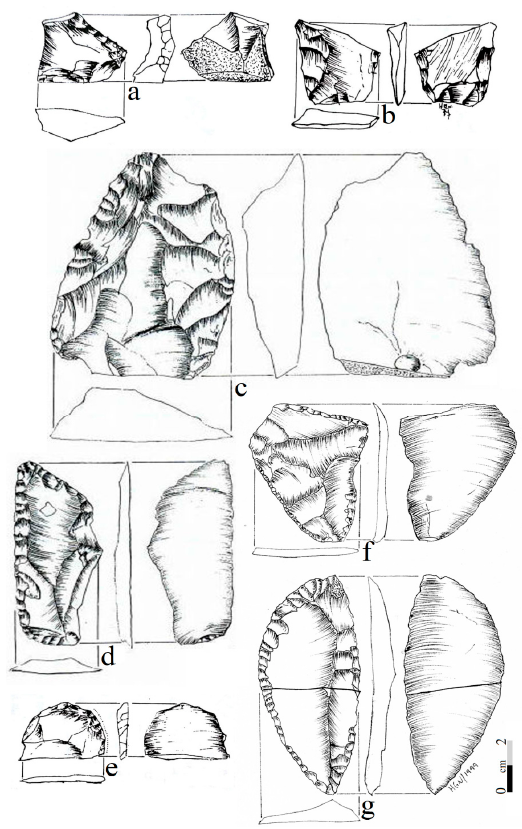
Figure 16. Drawings illustrating diverse Paleo-American flaked artifacts. ( a – e ) from the CM, ( f – g ) Fell’s cave. ( a , c–g ) Unifacial tools, ( b ) early manufacturing stage of a “fisthail” point.